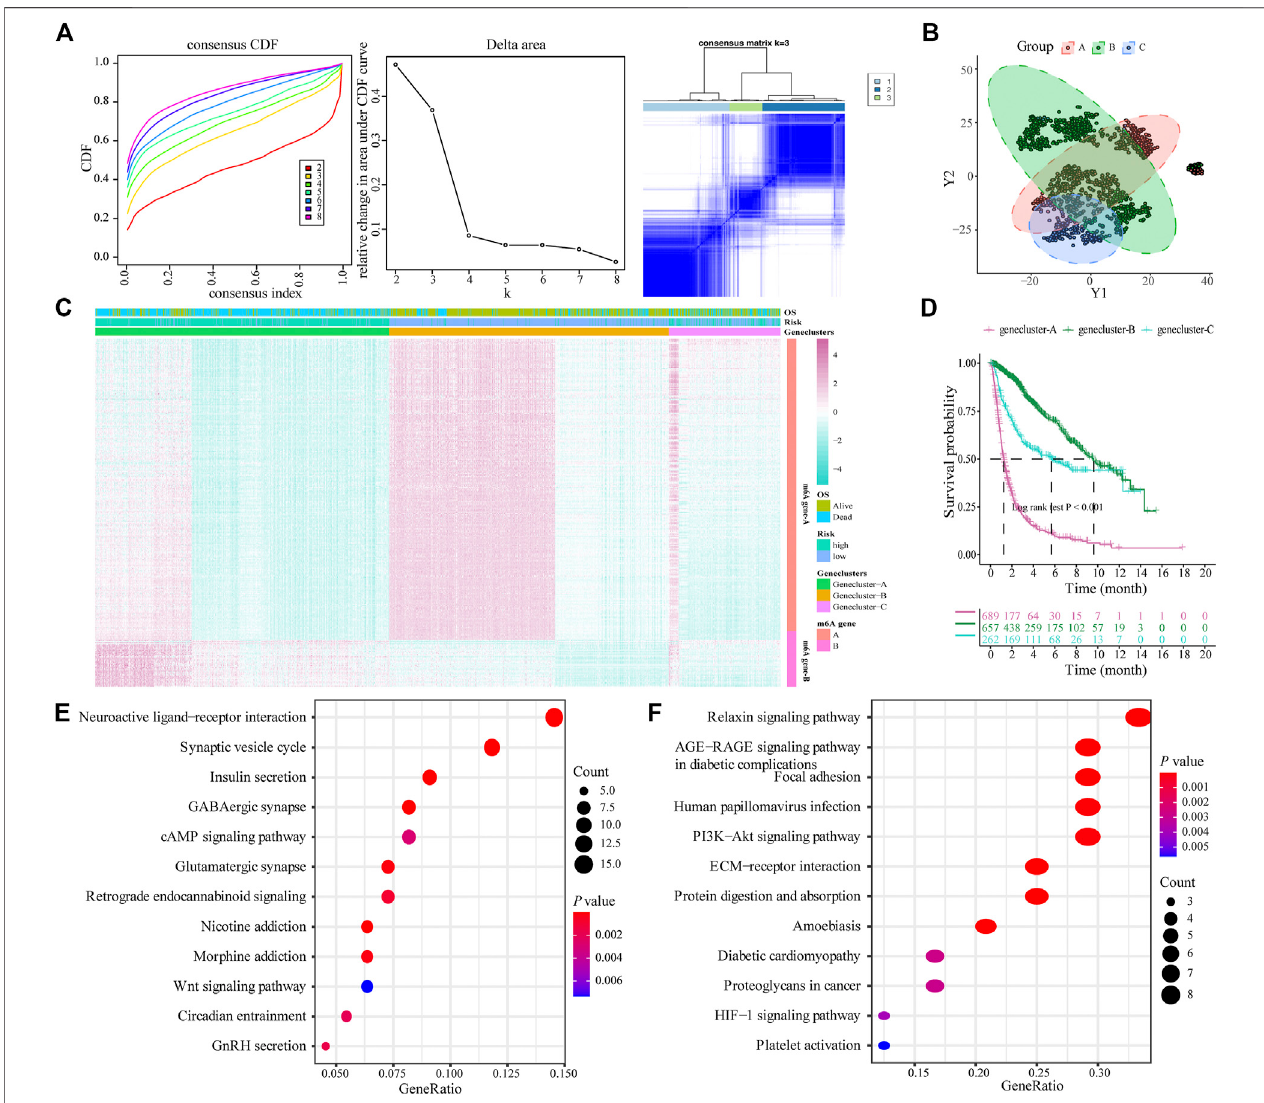
FIGURE 4 | Construction and functional annotation of an m6A gene feature model of patients with glioma. (A) Based on the expression characteristics of differentially expressed genes between high and low m6A risk score groups, unsupervised analysis and hierarchical clustering were performed, and patients were dividedintothree categories, calledgenecluster-A,-B, and-C; (B) tSNE analysisshoweddifferentialgeneexpression ingenecluster-A,-B, and-C; (C) Heat map shows theexpressionlevelsofcharacteristicgenesamongthethreeGeneclusters; (D) Survivalanalysisshowsthedifferentprognosisamonggeneclustergroups,among whichtheprognosisofpatientsinthegenecluster-Agroupistheworst; (E) TheKyotoEncyclopediaofGenesandGenomes(KEGG)analysisshowsthatSignaturegene- A is closely related to pathways such as synaptic vesicle cycle, insulin secretion, nicotine addiction, and GABAergic synapses; (F) KEGG analysis shows that Signature gene-B is closely related to the relaxin signaling pathway, AGE-RAGE signaling pathway in diabetic complications, ECM-receptor interaction, and protein digestion and absorption pathways.